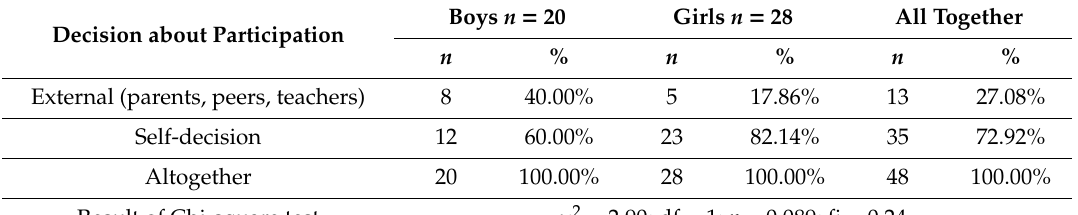
Table 5. Decision about start in the run by